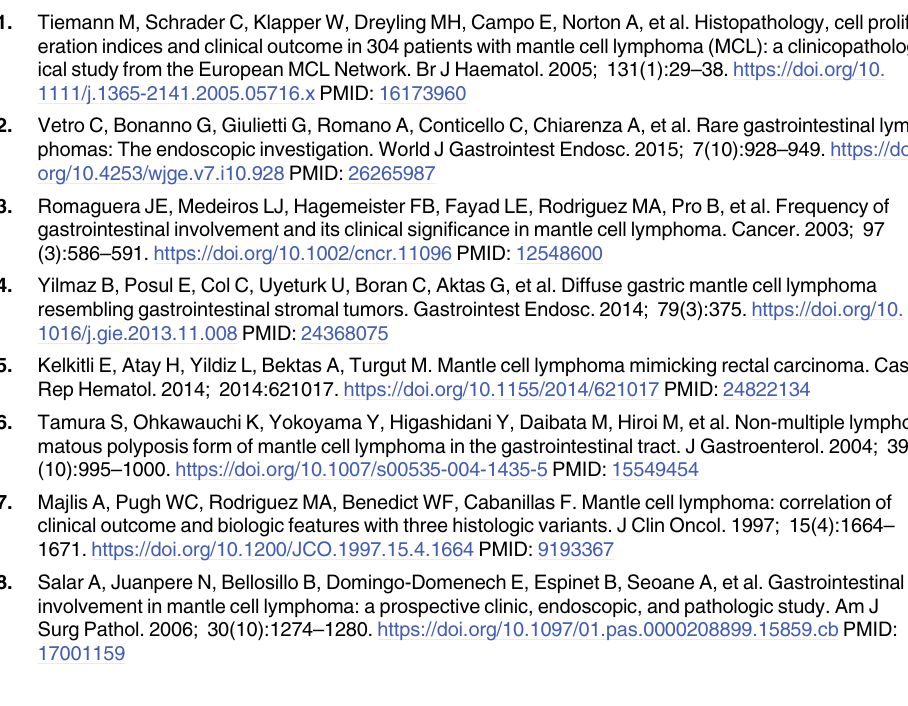
S1 Table. Data set of the included mantle cell lymphoma